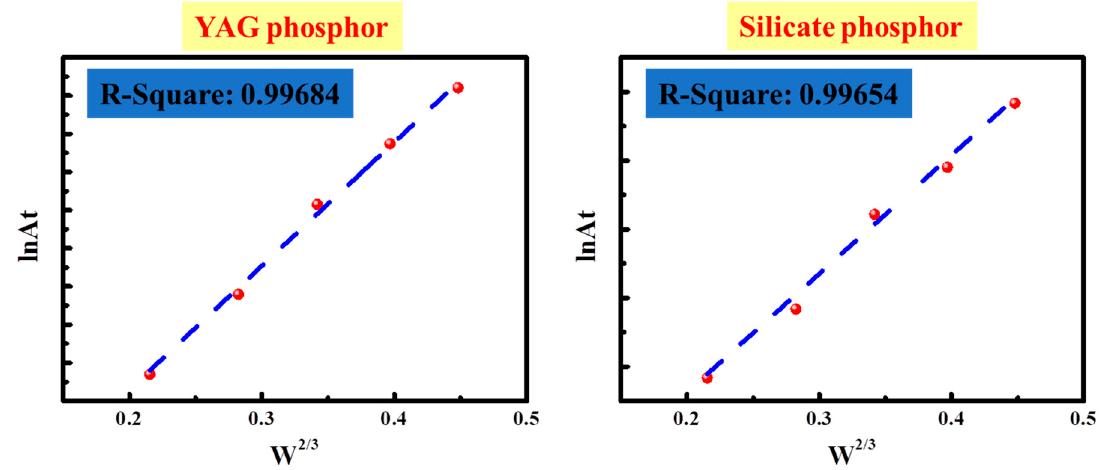
Figure 6. lnA t versus W 2/3 for YAG and silicate phosphors in real package.